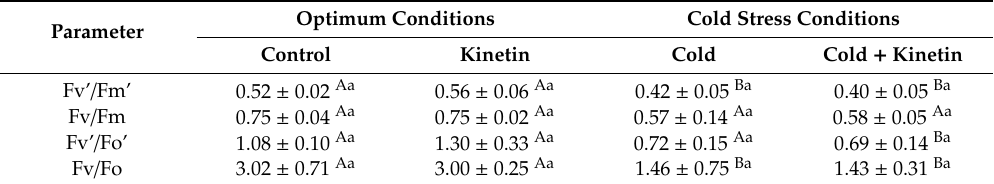
Table 3. The e ff ect of exogenous kinetin on maximum and e ff ective quantum e ffi ciency, expressed as ratios of variable to maximum and variable to initial PSII quantum e ffi ciency in the light and in the dark-adapted states in the leaves of co ff ee seedlings under optimum and cold stress